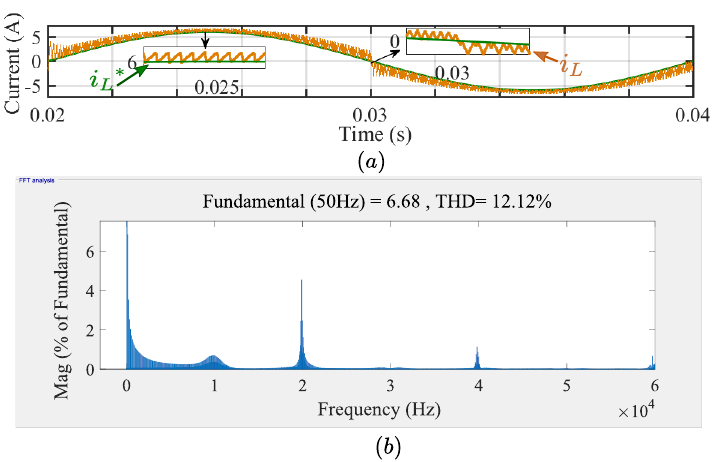
Figure 13. ( a ) Inductor current waveform obtained with the Sinusoidal reference. ( b ) Frequency spectrum of inductor current obtained with the Sinusoidal reference.